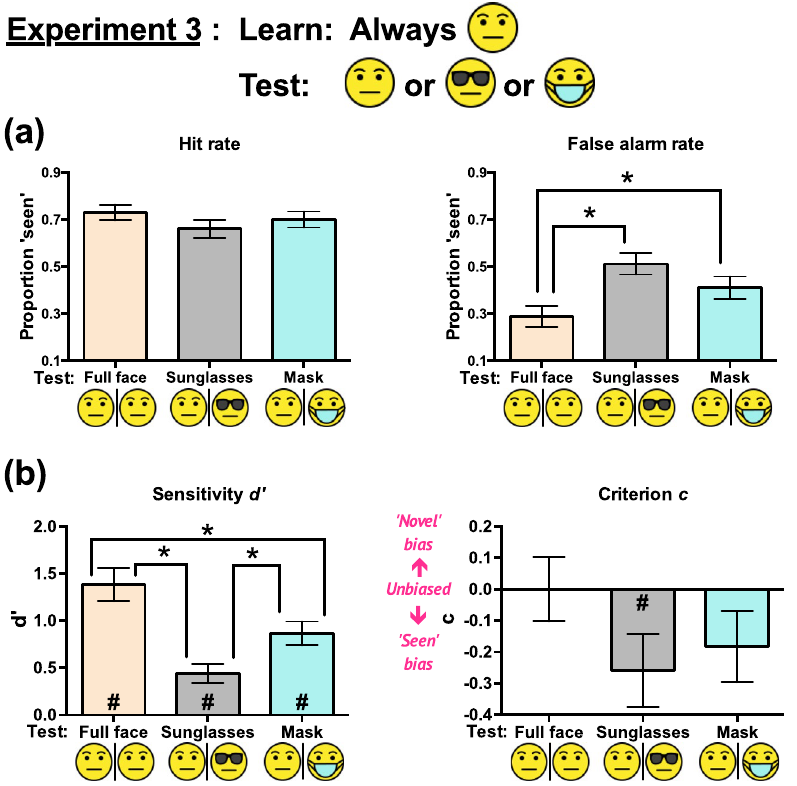
Figure 4. Experiment 3 results: ( a ) Hit rates and false alarm rates, and ( b ) sensitivities d’ and criteria c (indicating response biases) across the three conditions. All error bars represent ± 1 SEM. The asterisks (*) indicate significant pairwise differences between conditions. The hash signs (#) in ( b ) represent d’ or c significantly different from zero in the indicated conditions. The unmarked bars and comparisons were not statistically significant. The significance level was set at